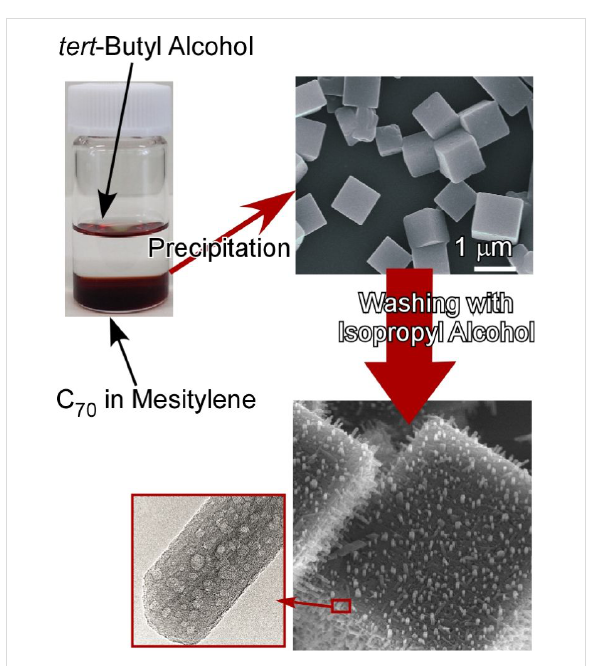
Figure 21: Three-dimensional cubic structures can be fabricated from C 70 molecules through an ultrasound-assisted liquid–liquid interfacial precipitation from tert -butyl alcohol and mesitylene. The formed cubes can be further transformed into needle-on-cube (one-dimensional structure on the surface of three-dimensional object) structures simply by washing with isopropyl alcohol at room temperature. Reproduced from [75], copyright 2019 The